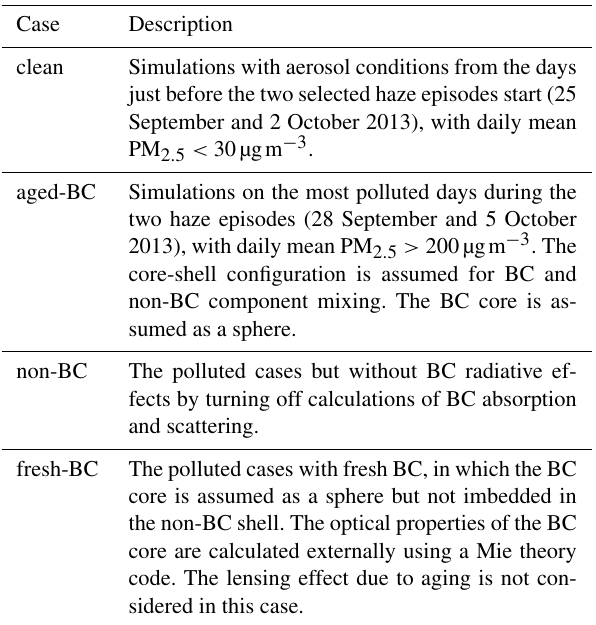
Table 1. List of numerical